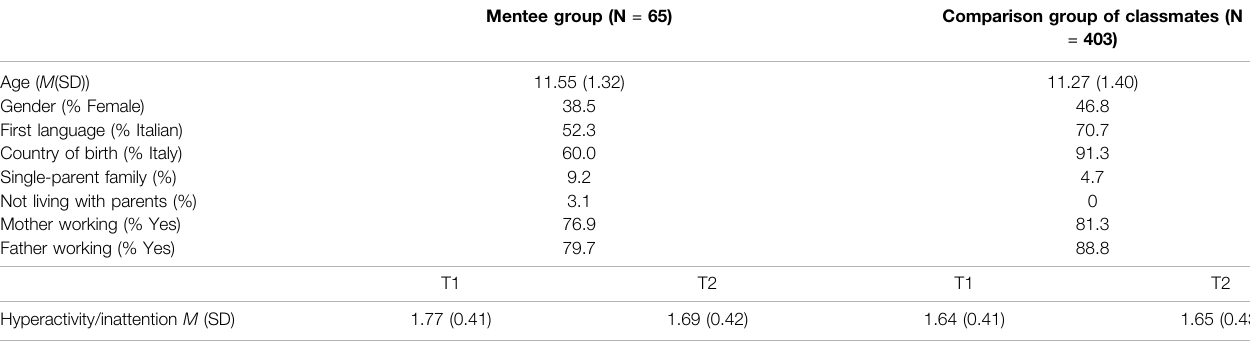
TABLE 1 | Sociodemographic information and descriptive statistics of the variables of interest.